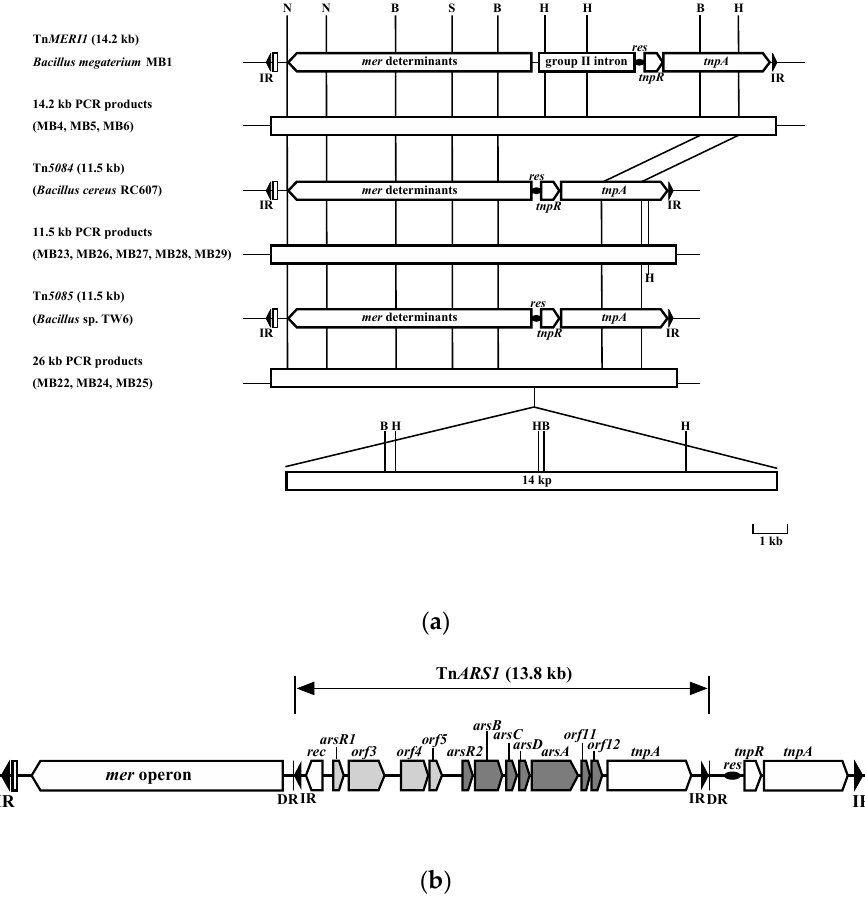
Figure 1. ( a ) The restriction fragment length profile of amplified PCR amplicons from mercury resistant Bacillus strains; ( b ) schematic representation of putative TnMARS1. Hatched boxes indicate the sequenced region.